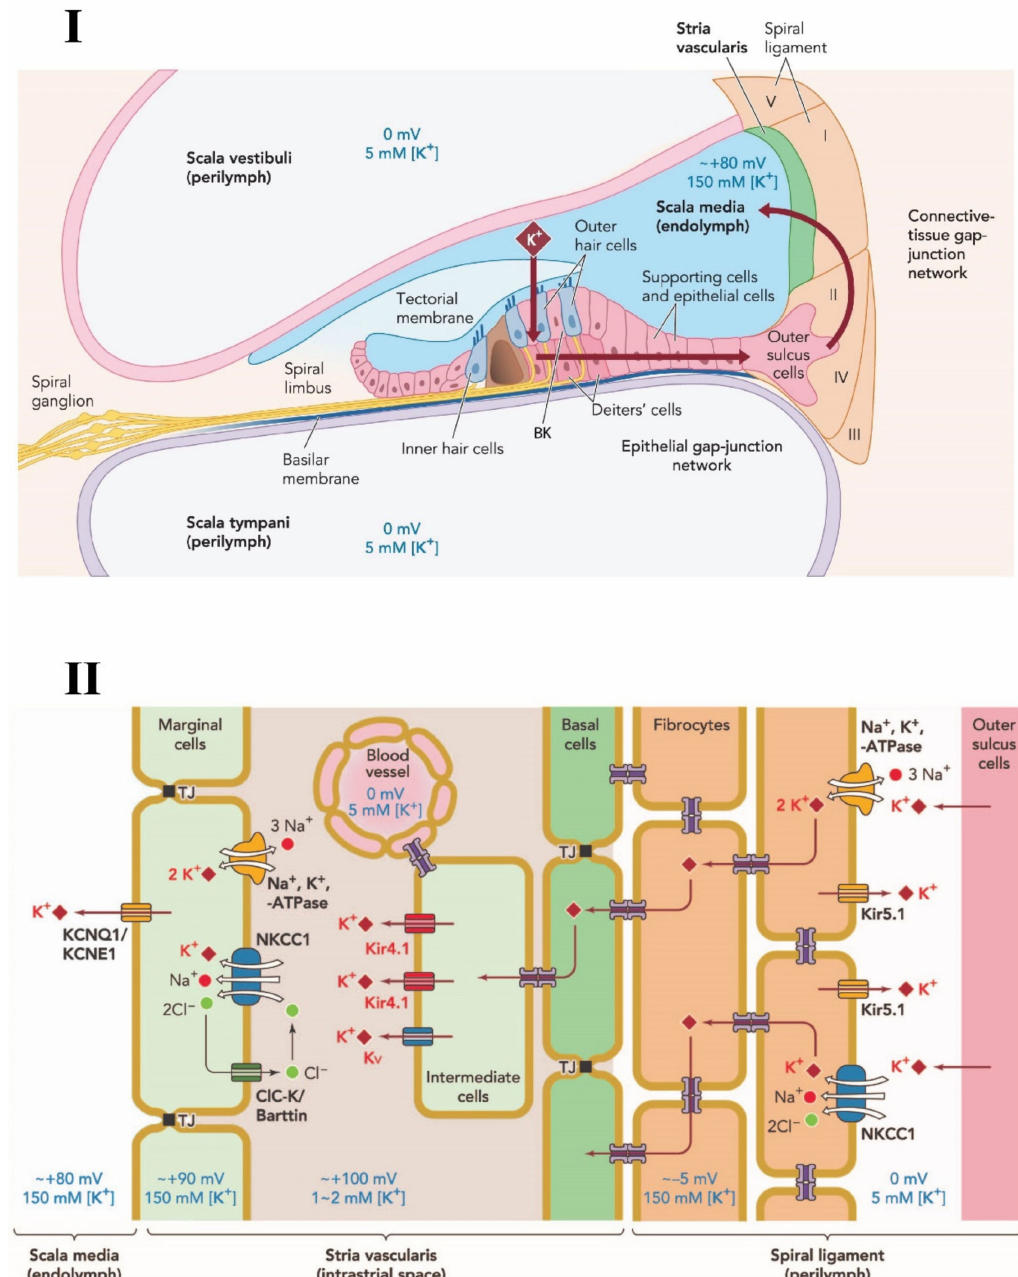
Figure 1. Schematic diagram of potassium circulation, ion channels and transporters in the cochlear lateral wall . ( I ) Potassium exits the hair cell and re-circulates into the endolymph of the scala media via various structures and ion channels in the supporting cells and lateral wall of the cochlea. ( II ) Various ion transporter channels; NKCC1; Na, K-ATPase; KCNQ1; Kir 4.1; Kir 5.1 and Kv, are expressed in the stria vascularis and spiral ligament that participate in potassium circulation and endocochlear potential generation. TJ: Tight Junctions. NKCC1, a key transporter in the cochlea, is expressed in spiral ligament and stria vascularis cells. Adapted from Hibino and Kurachi (2006) [25], with permission from the